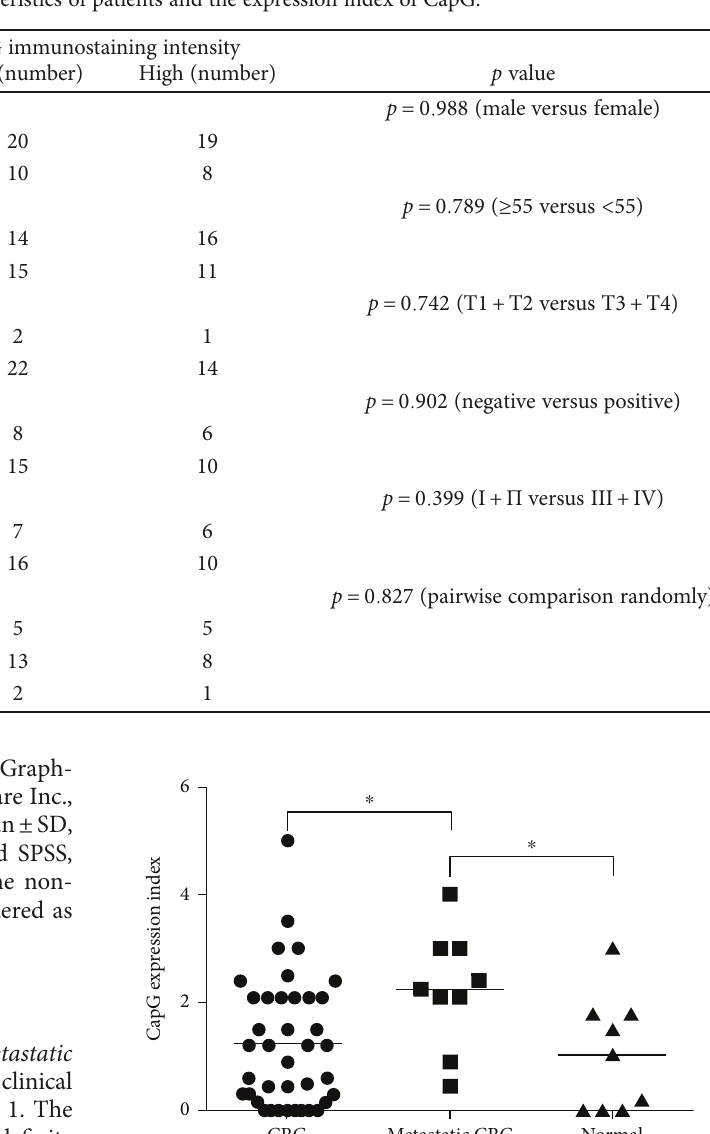
Table 1: Distribution of characteristics of patients and the expression index of CapG.